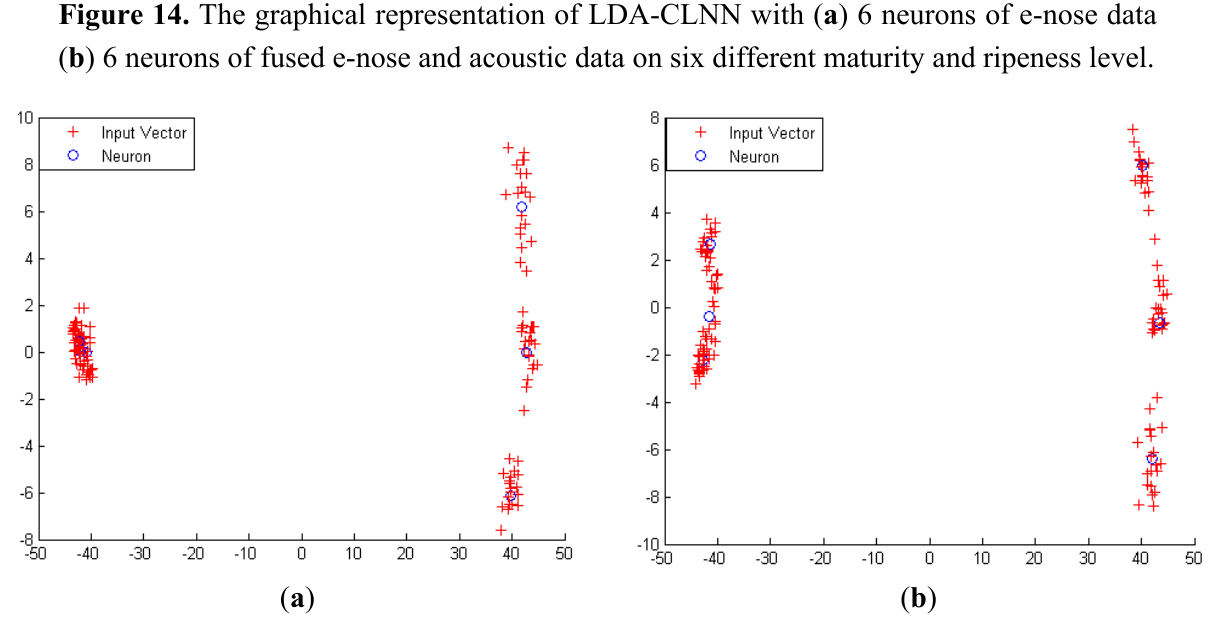
Table 10. ANN classification results using